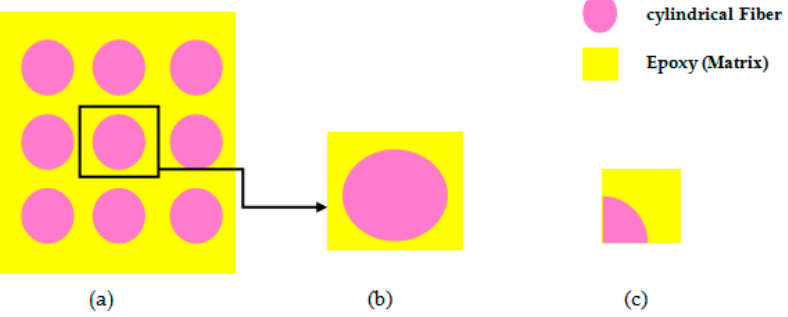
Figure 2. ( a ) Uniform distribution of fibers in the matrix; ( b ) Isolated Unit cell; ( c ) One-eighth Model.